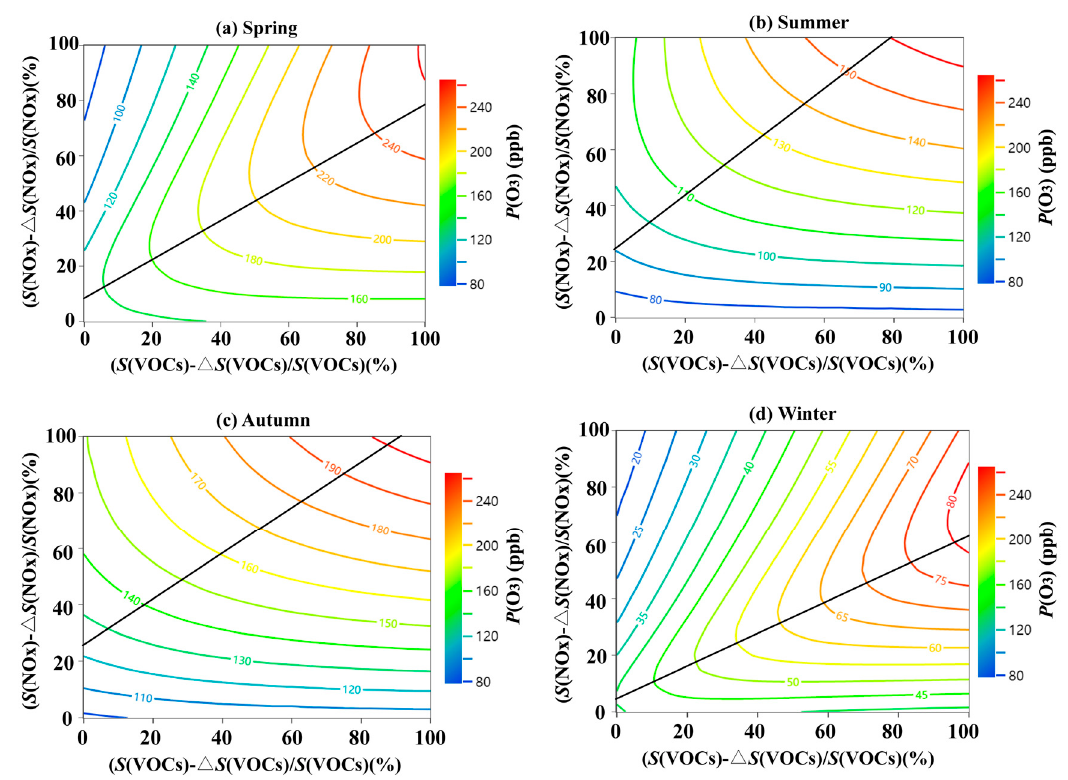
Figure 6. Isopleth diagrams of modeled O 3 production potential ( P(O 3 ) ) on S(VOCs) and S(NO x ) remaining percentages (i.e., (S(VOCs)- ∆ S(VOCs))/(S(VOCs)) and (S(NO x )- ∆ S(NO x ))/(S(NO x )) for four seasons in 2021 (( a ) spring, ( b ) summer, ( c ) autumn, ( d ) winter). The black line is a ridge